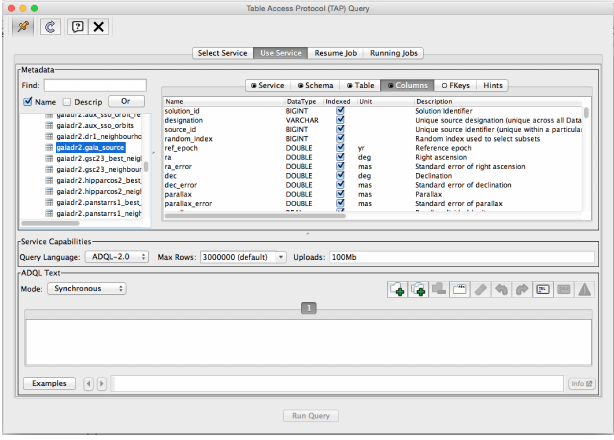
Fig. 57.— Columns for the Gaia DR2 data